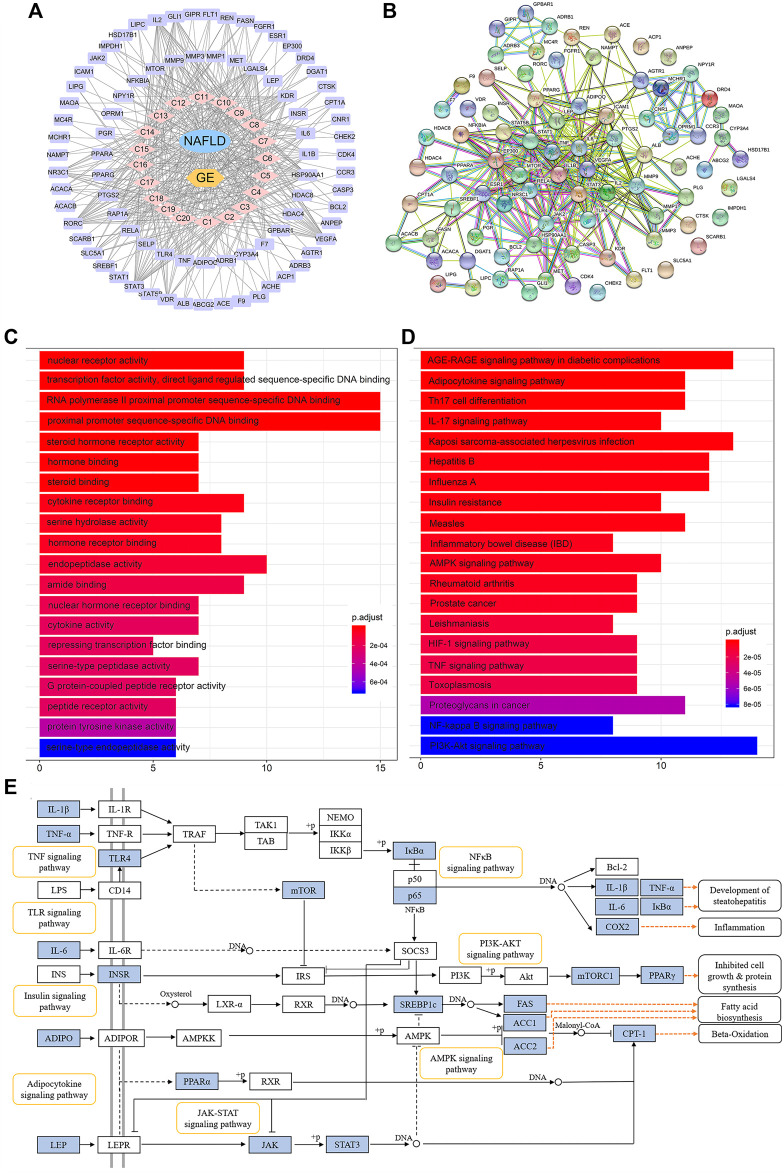
Network pharmacology analysis of the treatment of NAFLD with GE. (A) Disease-drug-component-target network. The lavender and pink circles represent targets and absorbed ingredients, respectively. A link indicates the interaction between nodes. (B) Protein-protein interaction network based on the STRING databases. The nodes represent proteins, and the edges represent protein-protein relationships. (C) GO terms of putative targets. (D) KEGG pathway terms of putative targets. In the GO and KEGG bar plots, the top 20 terms with p-value correction <0.05 are shown. (E) Representative signaling pathways mapping to putative targets. The blue nodes represent the putative targets of GE.